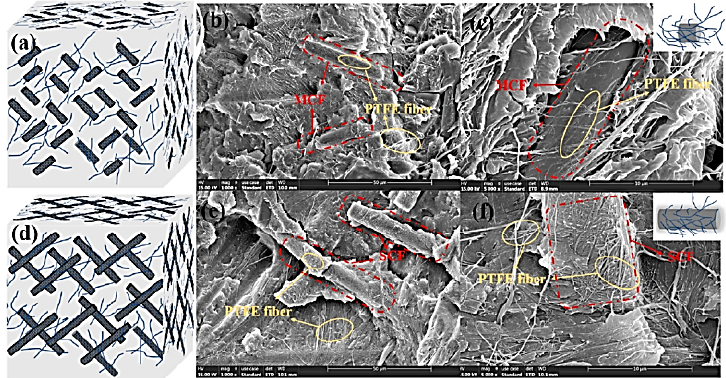
Figure 13. Schematic of ‘PPS/PTFE/MCF’ composites ( a ); structural morphology of ‘PPS/PTFE/MCF’ composites and enlarged view ( b , c ); schematic of ‘PPS/PTFE/SCF’ composites ( d ); structural morphology of ‘PPS/PTFE/SCF’ composites and enlarged view ( e , f ). Figure is reproduced with permission from reference [77].